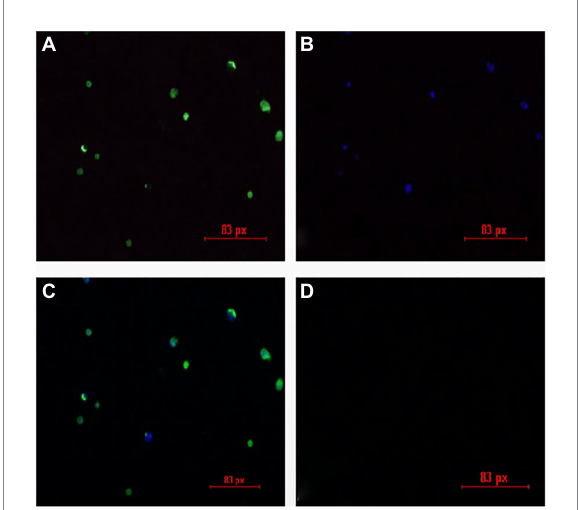
FIGURE 11 IFA results for the isolation of the chicken infectious anemia virus. (A) Positive cells are stained with FITC. (B) Positive cells are stained with DAPI. (C) Merge plot of FITC and DAPI. (D) Negative cells show no fluorescence.